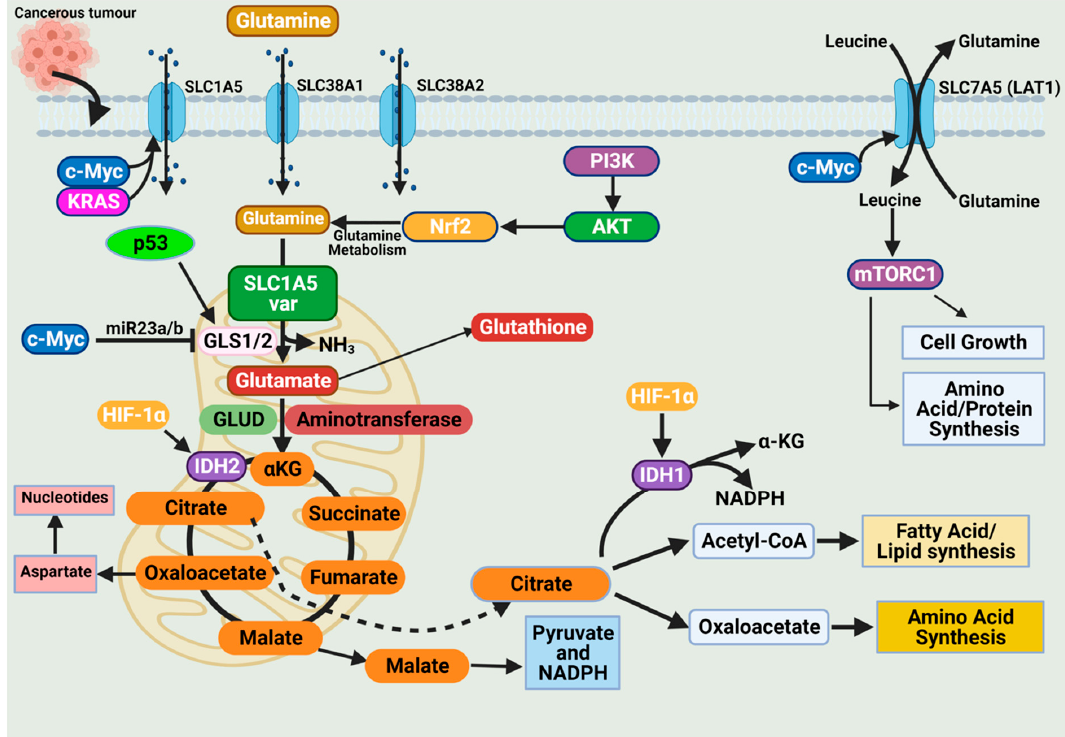
Figure 3. Glutamine import occurs through glutamine transporters and is utilized in various anabolic pathways such as nucleotides, lipid synthesis, and amino acid synthesis. Cancer cells exhibit a depen- dence on glutamine (i.e., glutamine addiction), and glutamine catabolism in the mitochondria generates metabolic intermediates to sustain cancer cell biomass. The dependence of cancer cells on glutamine is sustained by alterations in oncogenes and tumor suppressors. Expression of the glutamine transporter SLC1A5 is increased in various cancers to enhance their dependence on glutamine. Activation of the onco- genes KRAS and c-Myc further enhances SLC1A5 expression. The oncogene c-Myc indirectly regulates glutaminolysis through inhibition of miR23a/b, a microRNA involved in regulating GLS1/2 expression. The tumor suppressor p53 upregulates GLS2 expression and enhances glutaminolysis. Glutamine acti- vates the mammalian target of rapamycin complex 1 (mTORC1), which functions to support cancer